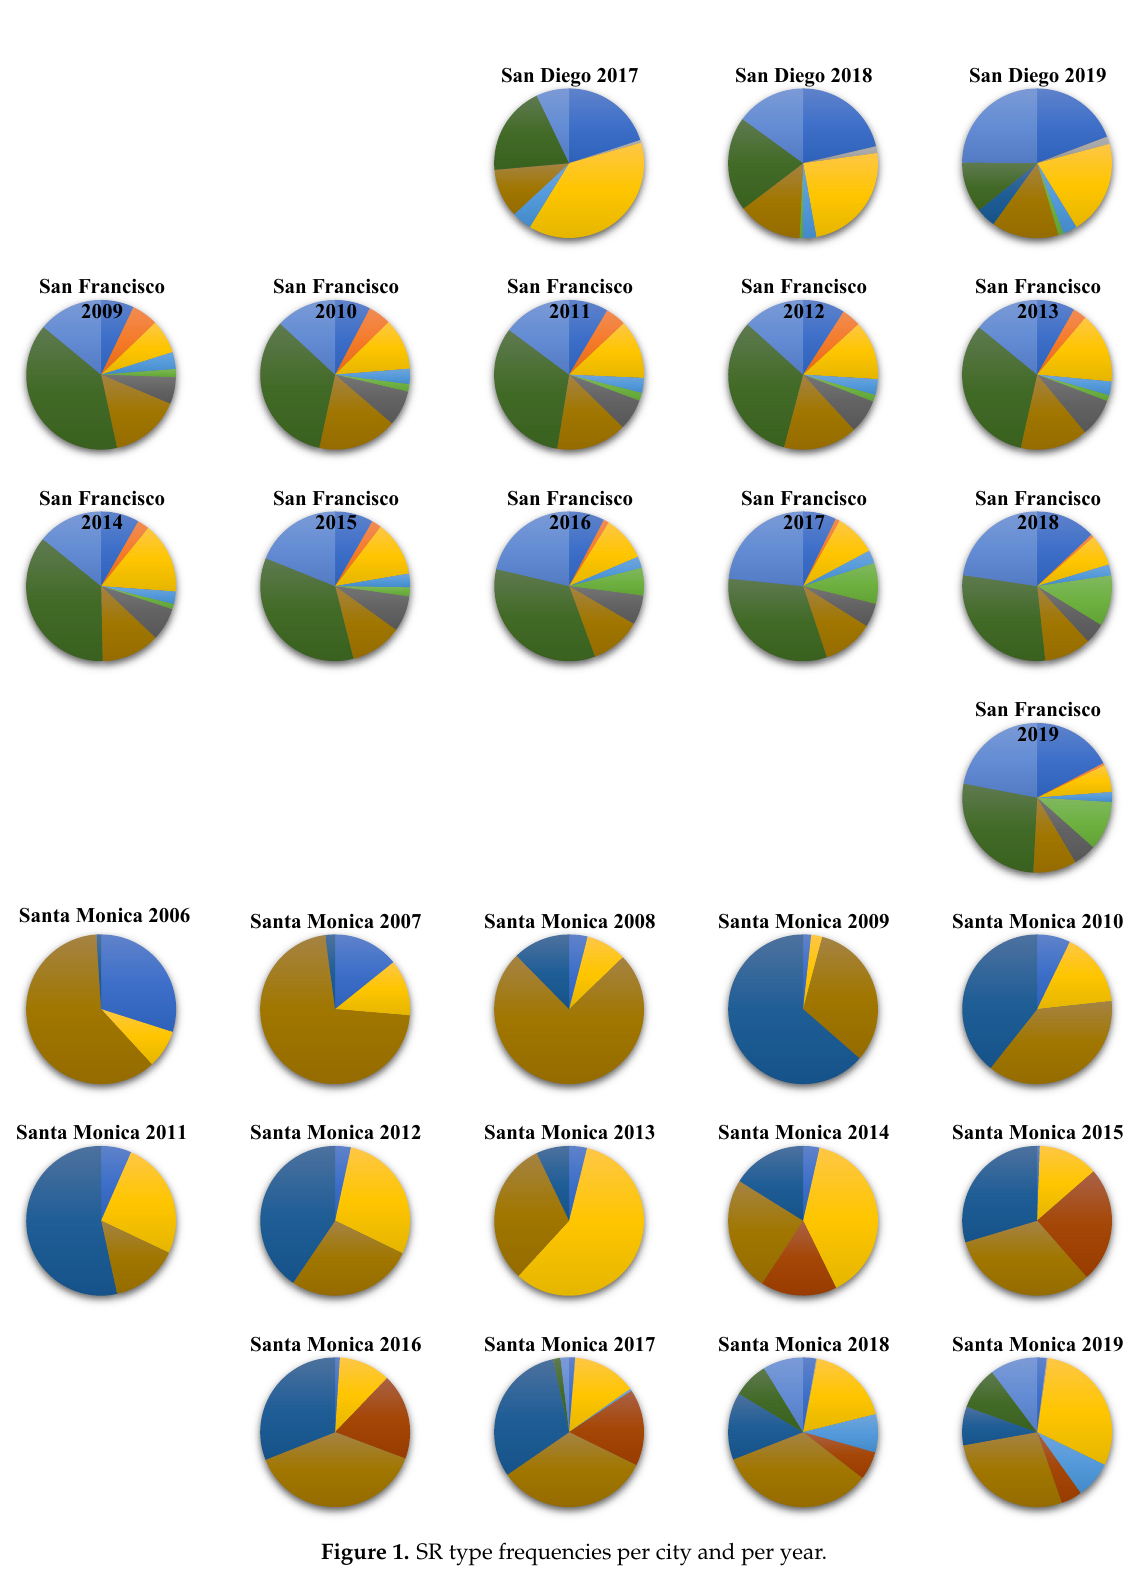
Figure 1. SR type frequencies per city and per year.